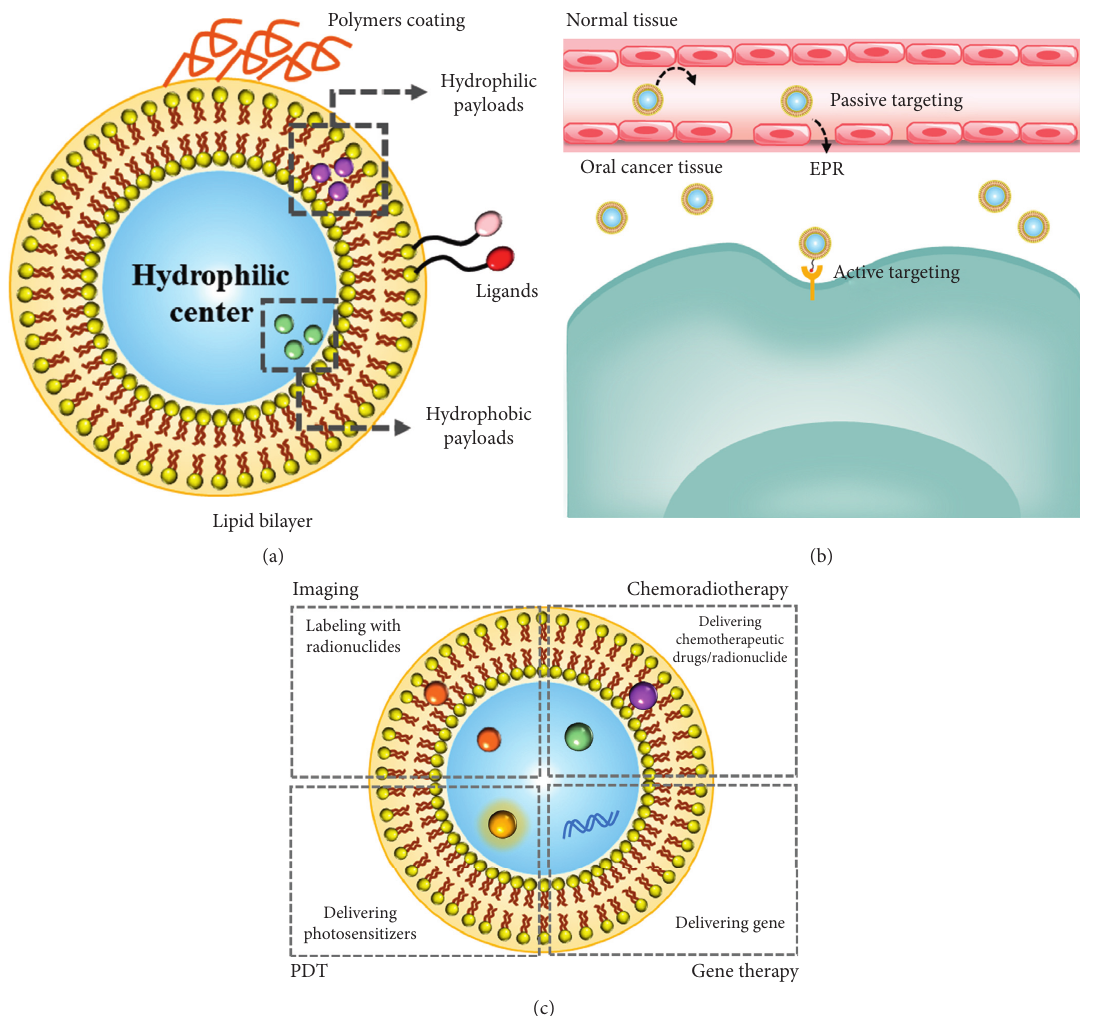
Figure 2: (a) The structure of liposomes. (b) The methods of liposome entering cancer tissue. (c) Diagnosis and therapy of